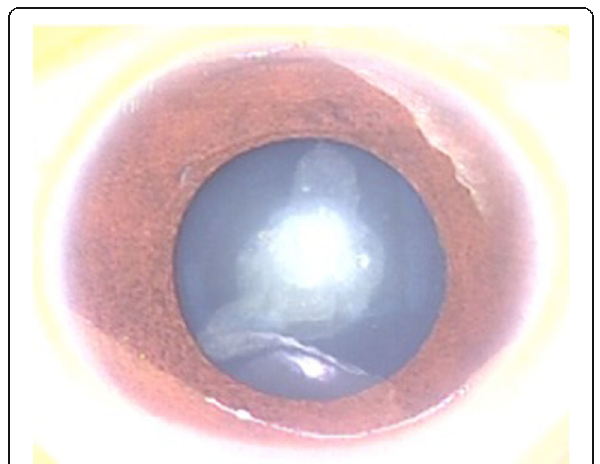
Fig. 2 Photograph of the right eye of the proband. The phenotype of the proband (IV: 1) was documented by ophthalmic operating microscope photography before surgery and shows a nuclear cataract and microphthalmia. The same phenotype was